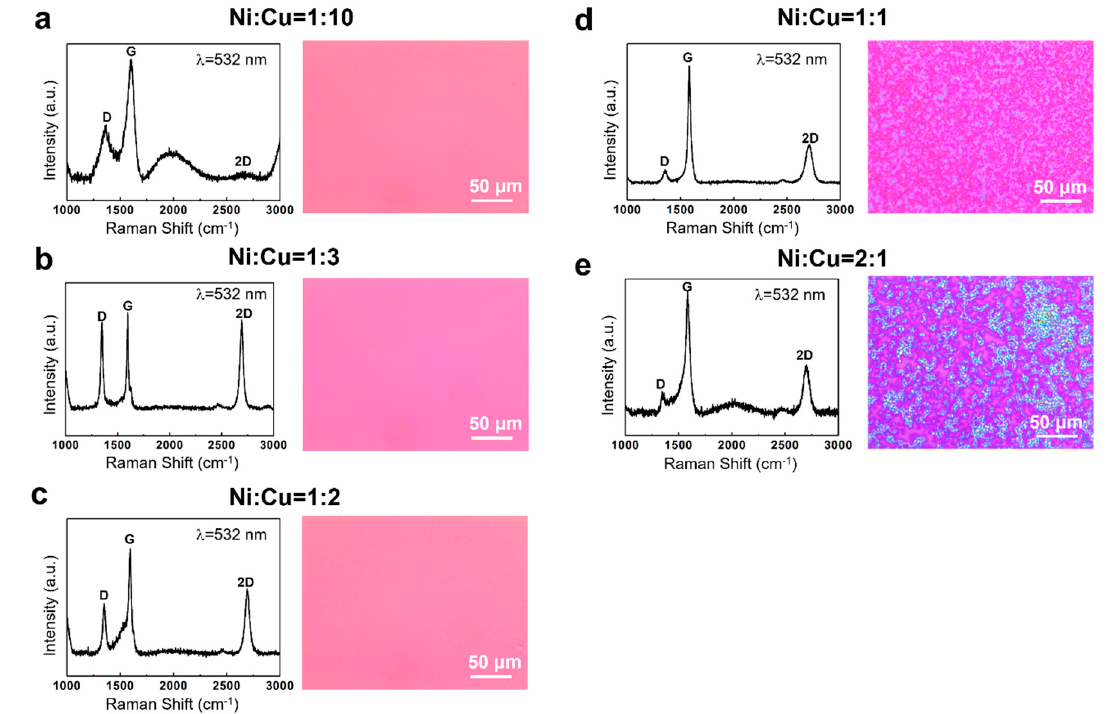
Figure 1. ( a )–( e ) The Raman spectra and corresponding optical images of the graphene on SiO 2 / Si substrates catalyzed by Ni–Cu alloys with different compositions (Ni:Cu = 1:10 ( a ), 1:3 ( b ), 1:2 ( c ), 1:1 ( d ) and 2:1 ( e ), respectively).